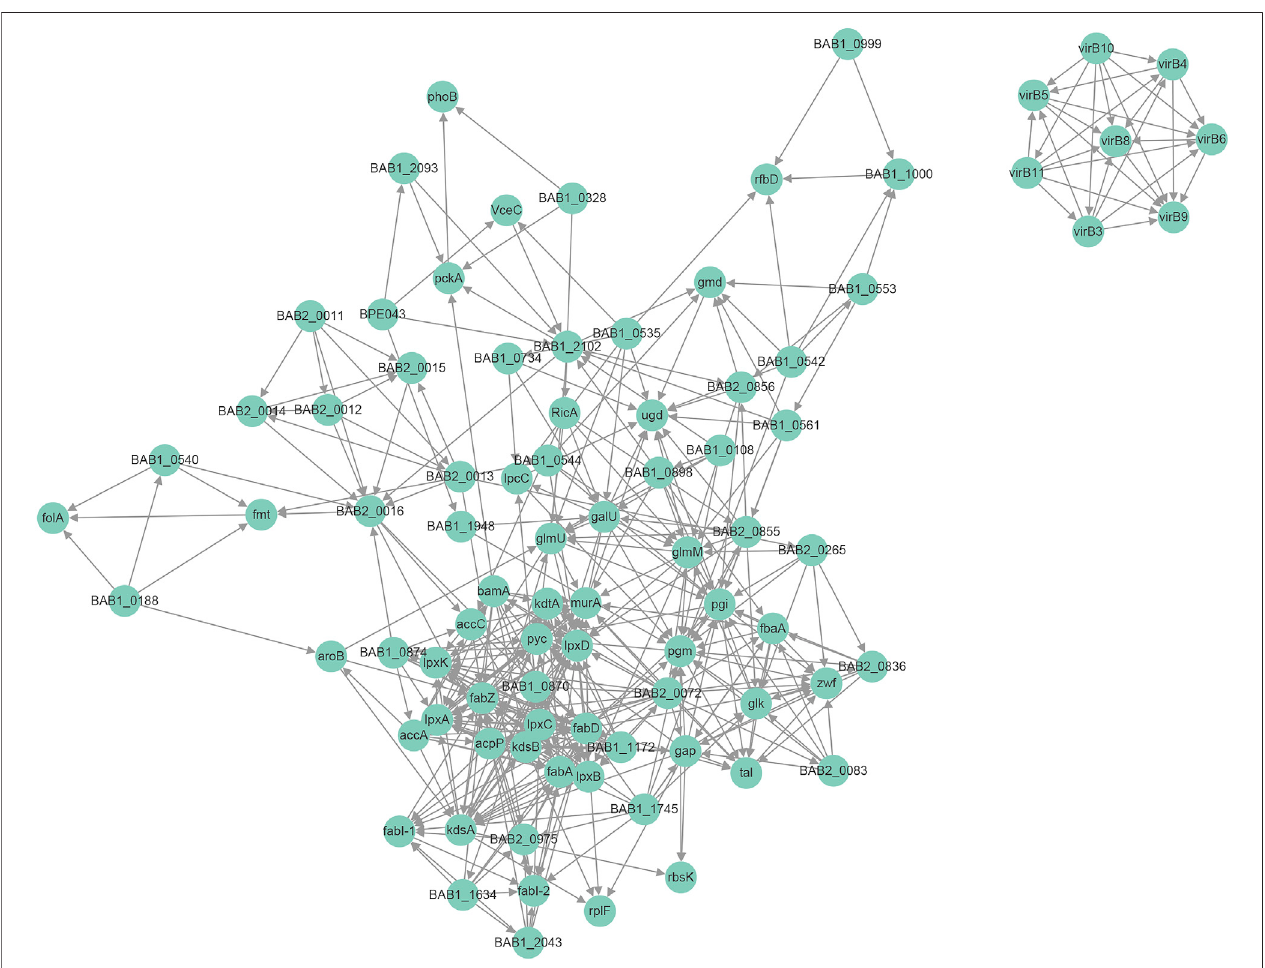
FIGURE 6 | Protein-protein interaction network for modi fi ed virulence raleated proteins corresponding to modi fi cation sites.